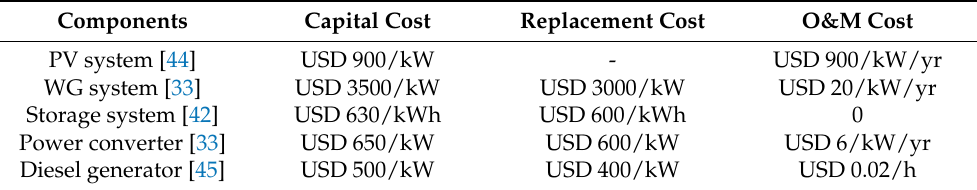
Table 2. Component